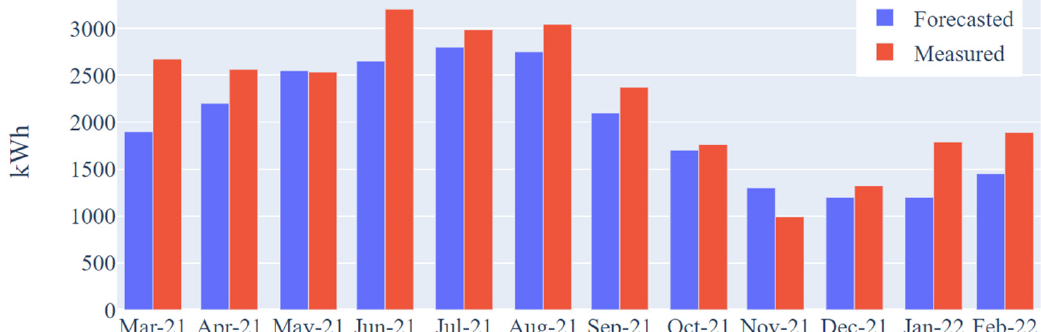
Figure 5. Forecasted and measured production in the period under analysis.